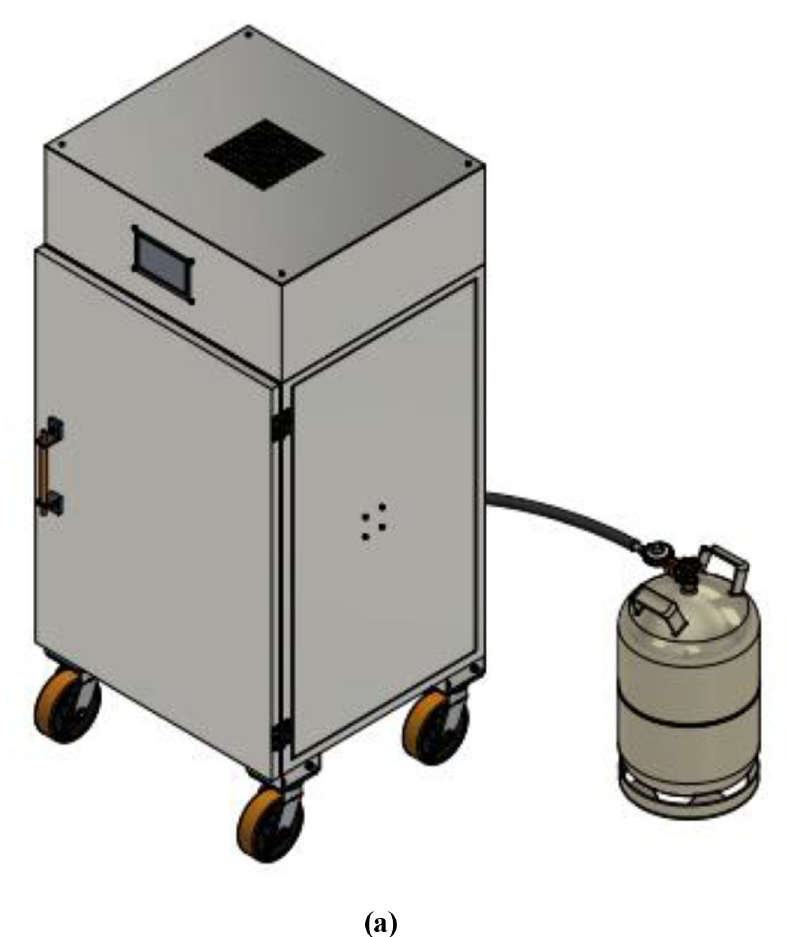
Figure 2. (a) Final outer structure of the dehydrator designed with AutoCAD inventor. (b) Dimensions of the oven in millimeters